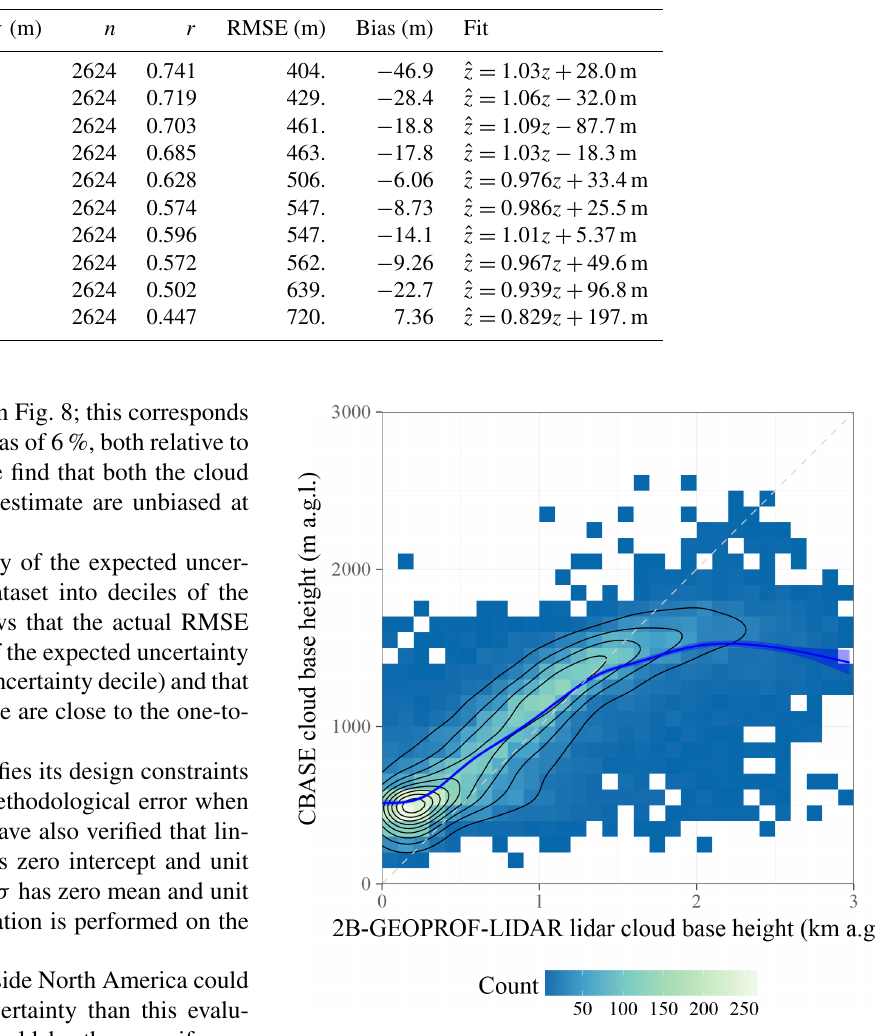
Figure 10. Scatter plot of 2B-GEOPROF-LIDAR lidar-only versus CBASE z . For description of the plot elements, see Fig. 3; because both cloud base measures have comparable uncertainty, linear re- gression is a misleading diagnostic (Pitkanen et al., 2016) and has not been included. The mean difference between 2B-GEOPROF- LIDAR and CBASE is 0.05km, the root-mean-square difference is 0.41km, and the correlation coefficient is 0.79.